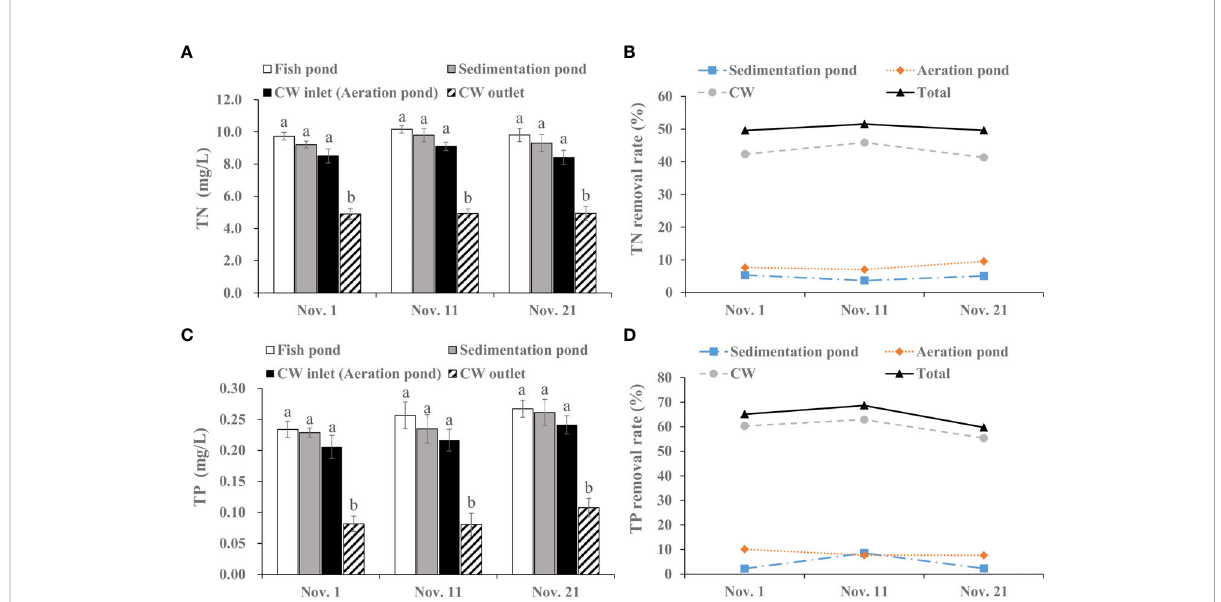
FIGURE 3 Removal ef fi ciency of integrated CW system on TN and TP during the ef fl uents discharge period. (A) TN value in the fi sh pond, sedimentation pond, CW inlet (aeration pond) and CW outlet. (B) TN removal rate of the sedimentation pond, aeration pond and CW. (C) TP value in the fi sh pond, sedimentation pond, CW inlet (aeration pond) and CW outlet. (D) TP removal rate of the sedimentation pond, aeration pond and CW. The value is expressed as mean ± SE (n = 5). Different small letters in bar graph indicate signi fi cant difference ( p < 0.05) among the fi sh pond, sedimentation pond, CW inlet (aeration pond) and CW